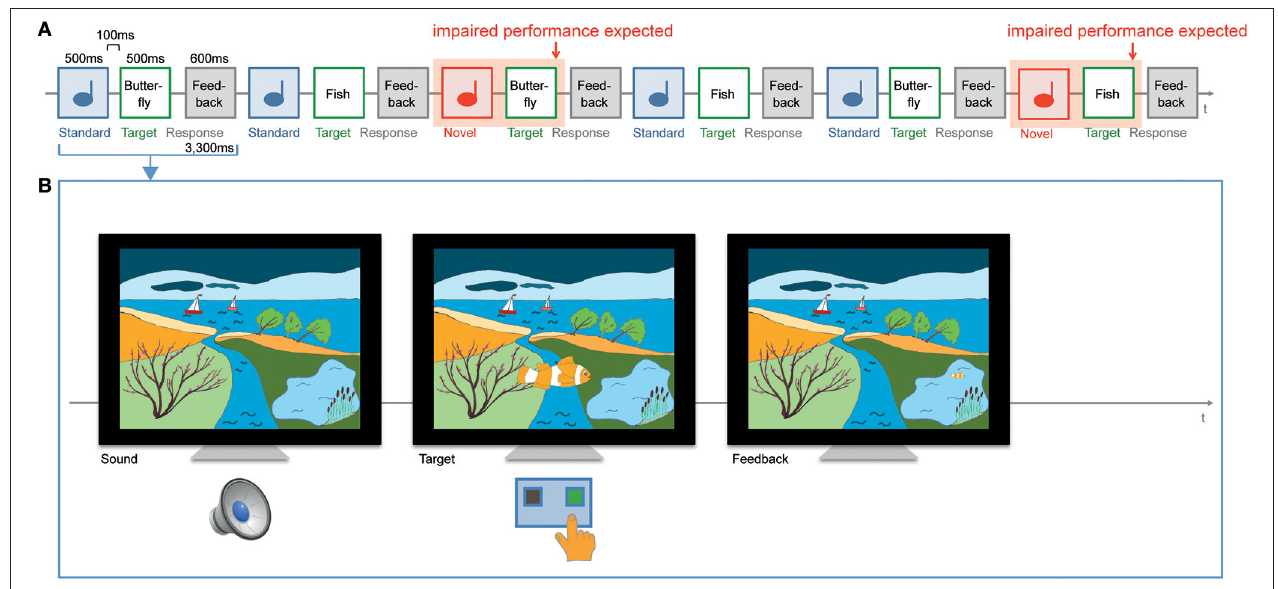
FIGURE 1 | Displays the distraction paradigm including trial structure. (A) Rarely and randomly presented novel or pitch-deviant sounds were presented within a sequence of repeated standard sounds (an example of the novel condition is displayed). Sounds were not relevant for the categorization of the following targets (e.g., butterflies and fish). (B) Children were asked to distinguish targets by “guiding” target objects to the place where they usually feel comfortable. For example a butterfly would prefer the flowering shrub that is located on the left side and a fish would prefer the pond located on the right side. In the displayed scene the child has to press the right button when a fish appears. After a correct response the fish swims in the